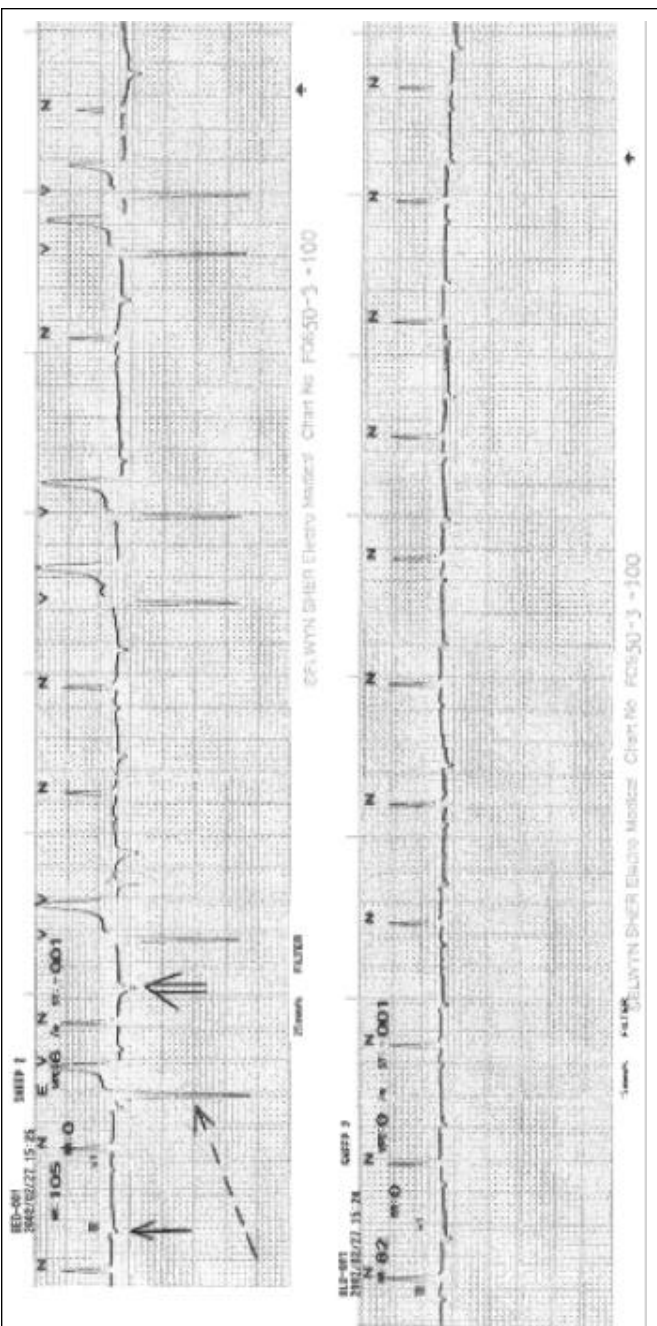
Example 1—cardiac memory,